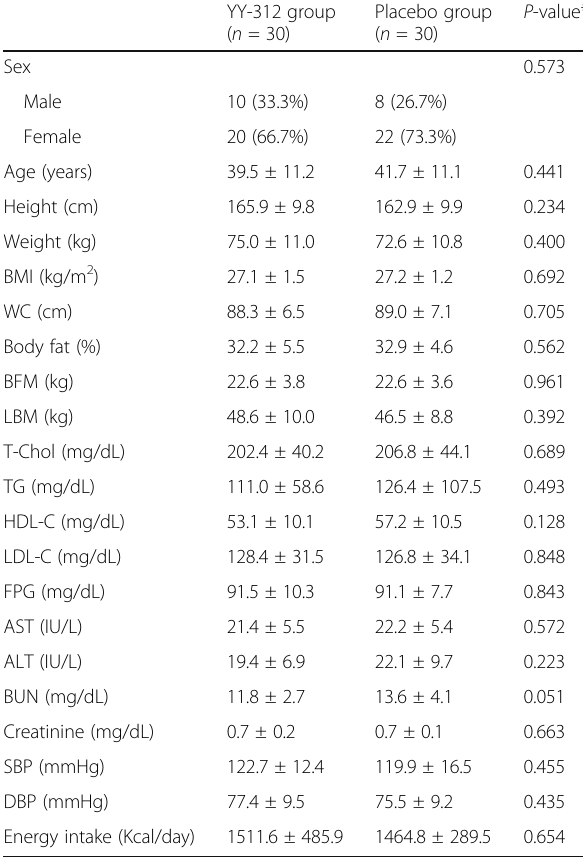
Table 2 Baseline characteristics of study